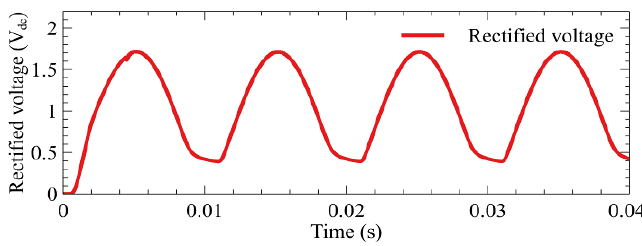
Figure 6. Stored rectified voltage in C L1 .